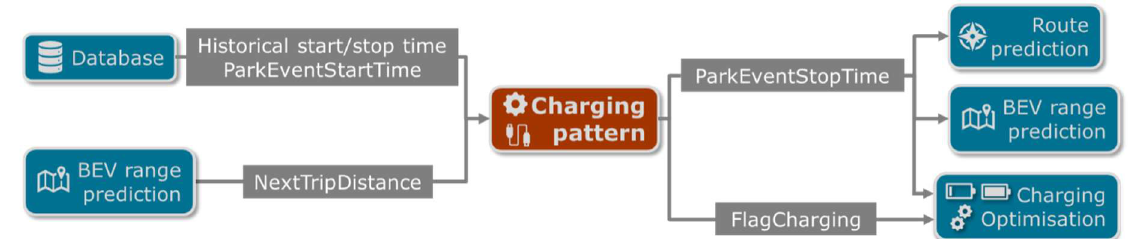
Figure 5. Charging pattern algorithm interaction.